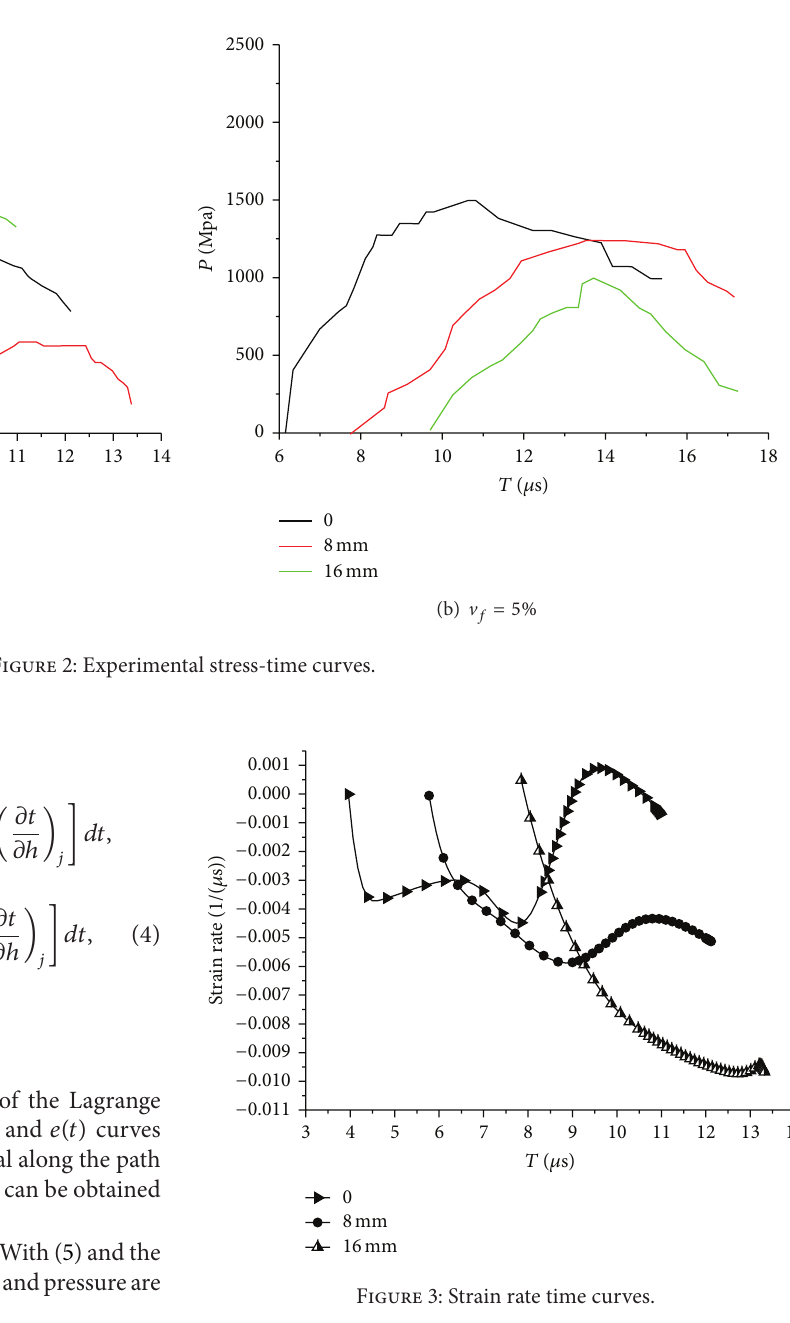
Figure 3: Strain rate time